Question: In one sentence, what is this figure communicating?
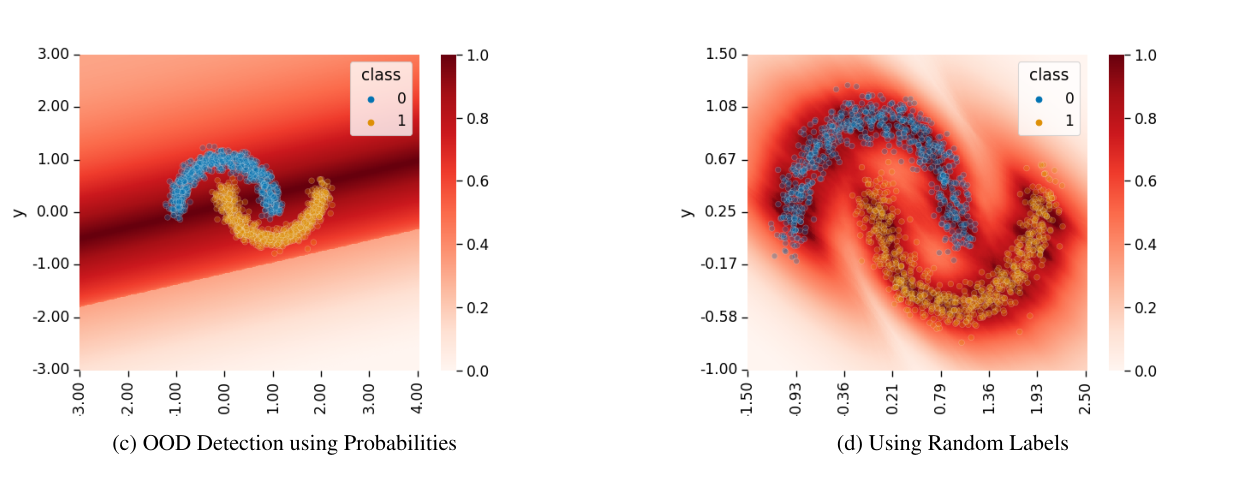
Answer: Illustrating a case where quantile representations do not capture the distribution perfectly. (a) Original Dataset. (b) The region detected as in-distribution by using quantile representations. (c) Region detected as in-distribution by using the outputs from a single classifier. Observe that quantile representations still perform better than single classifier outputs. (d) Using random labels instead of ground-truth. Observe that the two moons structure is faithfully preserved in this image. The brightness of Red indicates the chance of being in-distribution.